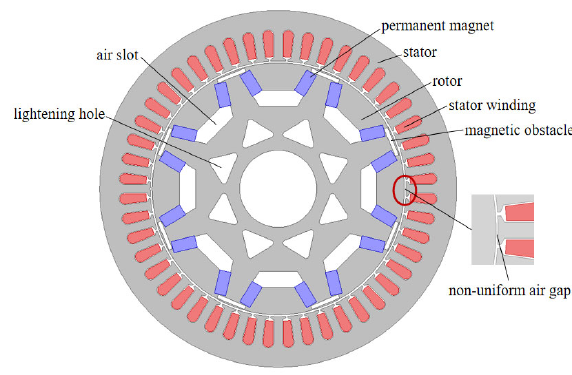
Figure 3. ( a ) Rotor structure diagram of IPMSM; ( b ) rotor structure diagram of IPMSMA.